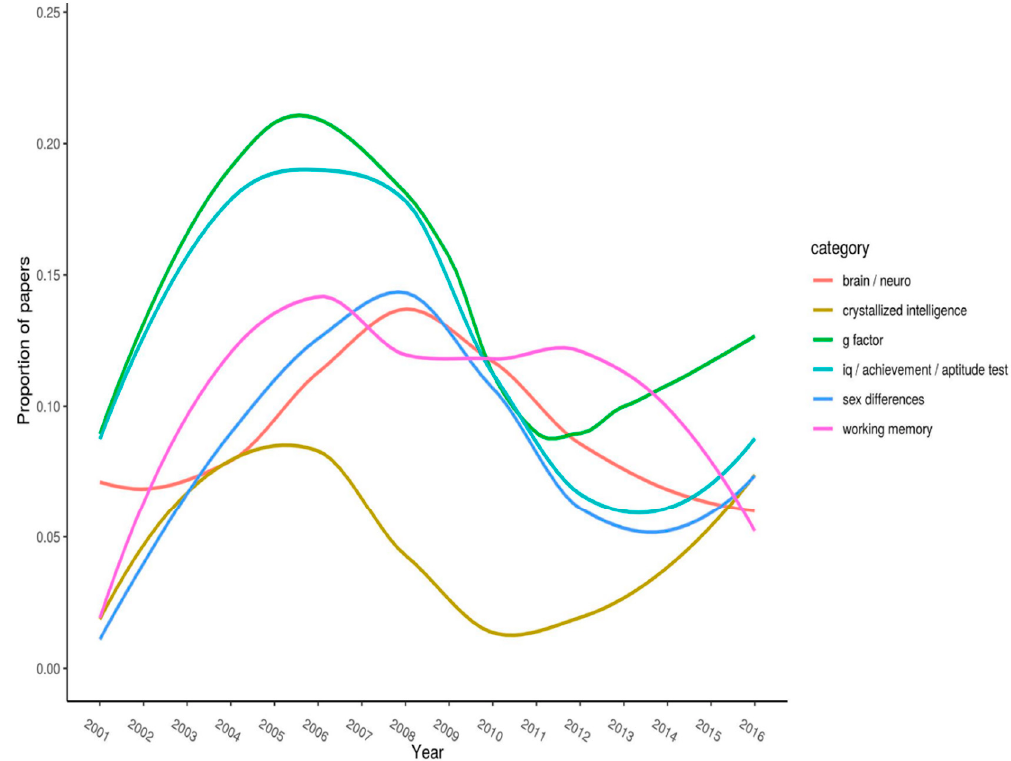
Figure 1. Proportion of articles each year that list a given keyword (flat).